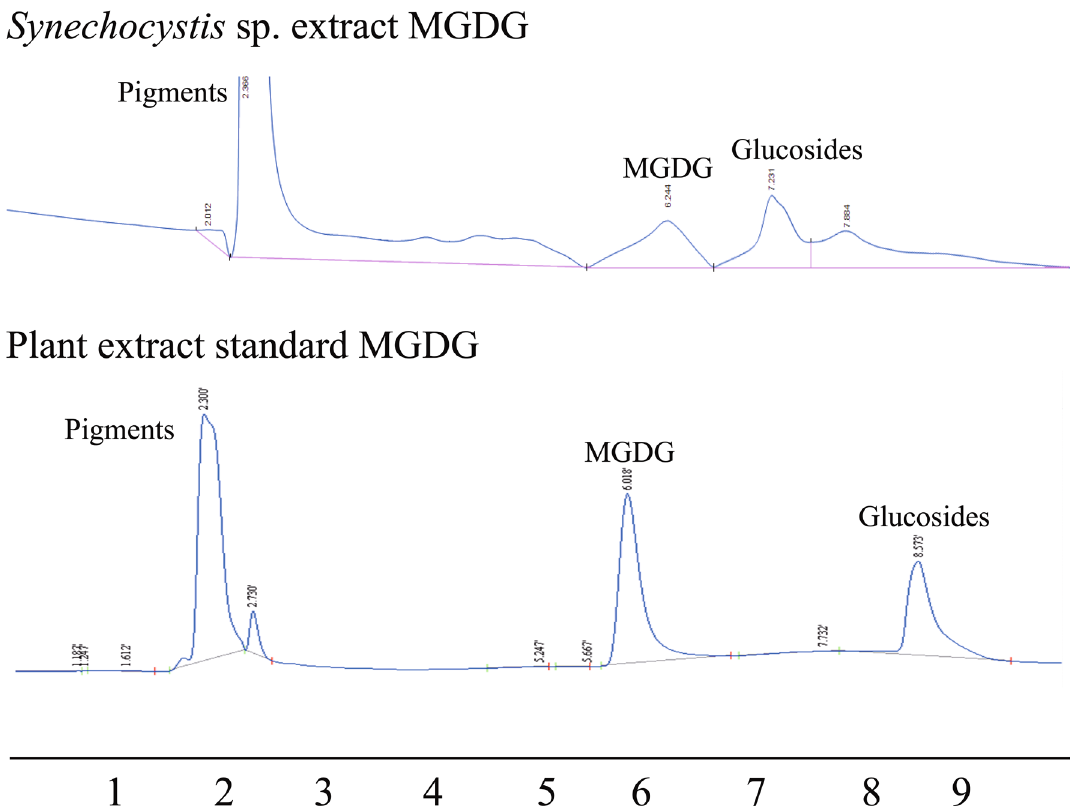
Figure 6. HPLC–UV analysis of MGDG extracted from Synechocystis sp. PCC 6803 (upper panel) and MGDG standard (lower panel). The MGDG peak was obtained at ~ 6 min for the MGDG molecule from both of the sources. The peaks obtained at ~ 2 and ~ 7–8 min represent the pigments and glucosides peaks eluted with the methanol/ water